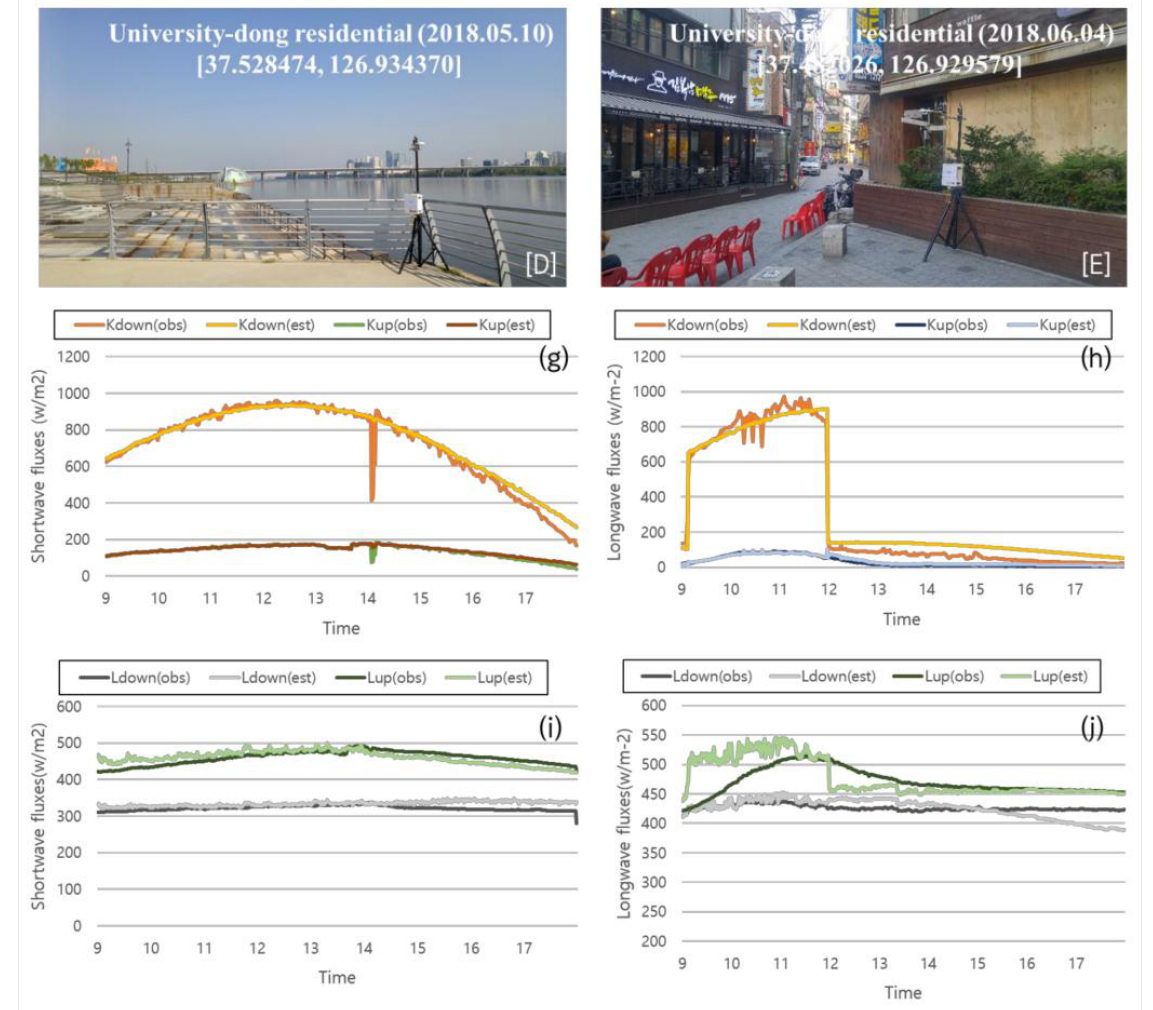
Figure A3. The clear-sky solar radiance of street canyons for a day in high-density and low-building environments in various places. ( D ) University-dong residential on 10 May 2018 and ( E ) University- dong residential on 4 June 2018. Comparison between measurement and estimated radiation ( g )–( j ).